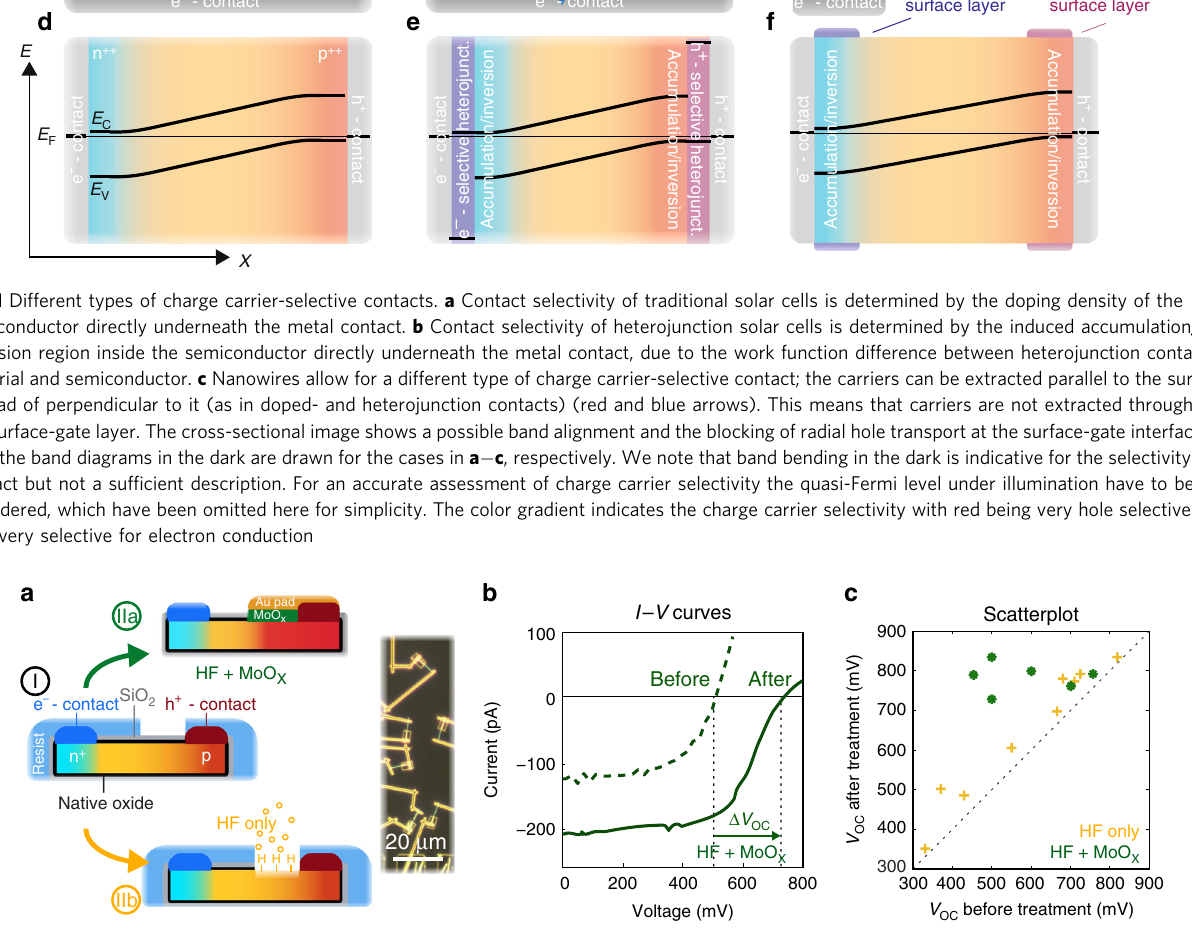
Fig. 2 Improving carrier selectivity with MoO X . a Schematic of experimental setup. Contacted single InP nanowire p-i-n junction solar cells are coated with electron-beam resist. A window is opened in the resist next to the hole contact to test the device characteristics before any treatment (I), after HF (IIb) or after HF and 30 nm MoO X layer evaporation (IIa). To prevent degradation of the MoO X work function due to ambient contaminants, a 100 nm Au capping layer (orange) has been evaporated. The right side shows an dark- fi eld optical microscope image of single nanowire solar cells before surface treatment, where the resist windows are visible. b I − V curve before and after HF + MoO X treatment. The vertical dashed lines indicate the open-circuit voltage. c Scatter plot showing each single nanowire solar cell V OC before and after HF etching (yellow) or HF etching + MoO X evaporation (green)